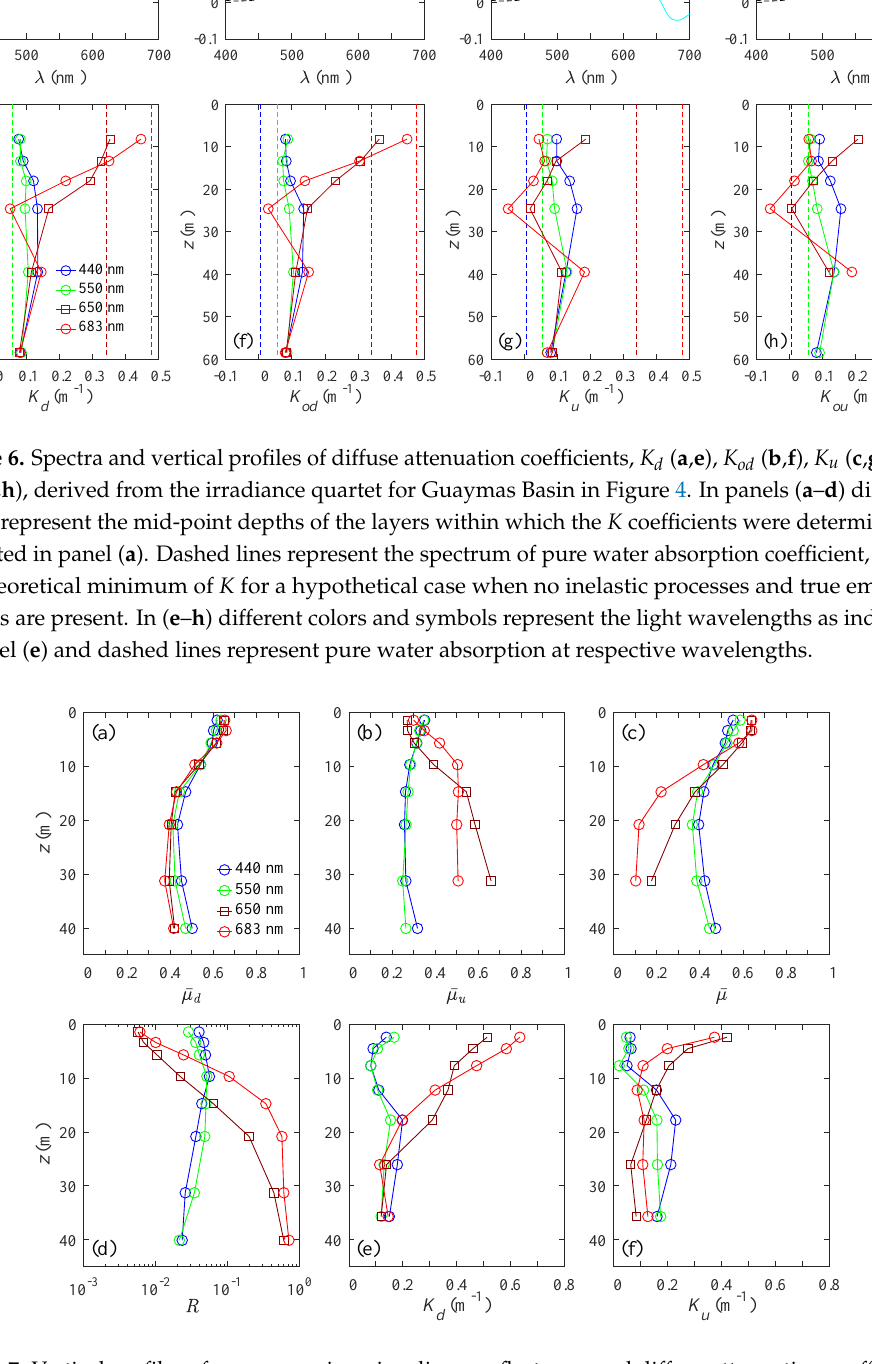
panel ( a ); µ ( b ); µ ( c ); R ( d ); K d ( e ); d u